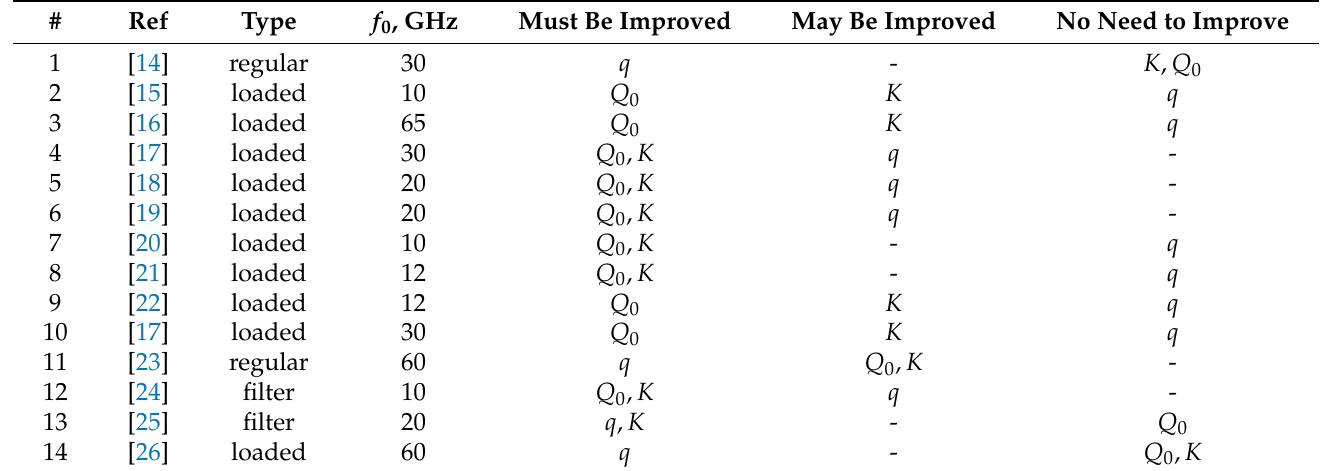
Table 2. Priorities to improve the phase-shifter